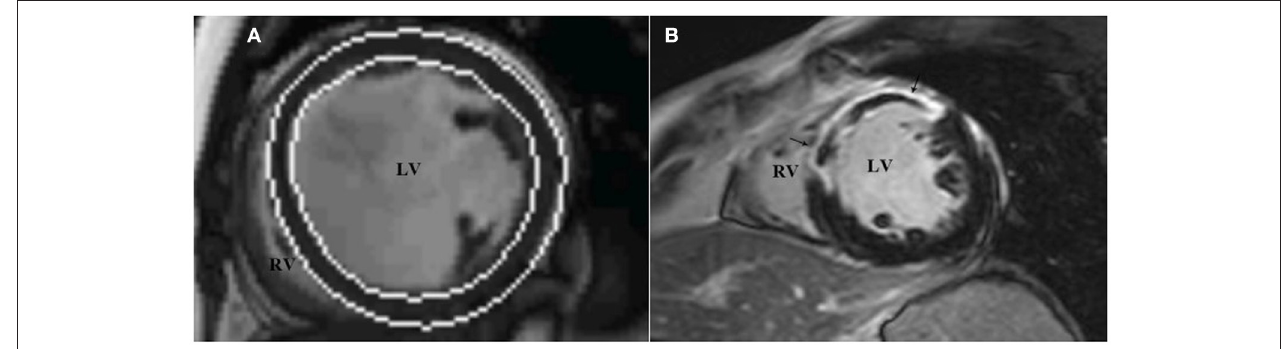
FIGURE 3 | LV function and LGE analysis via cardiac magnetic resonance imaging. The analysis software automatically tracks the left ventricular endocardium and epicardium to measure left ventricular volume (A) , and assesses the presence and distribution of left ventricular LGE through short-axis images (B) , which show high signal intensity in the middle segment of the left ventricular septum, anterior wall. LGE, late gadolinium